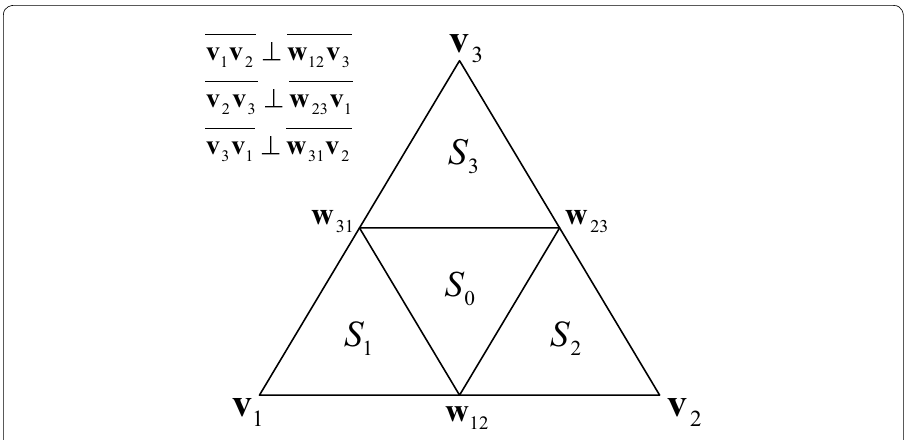
Fig. 6 Partitioning of the 2-simplex according to Definition